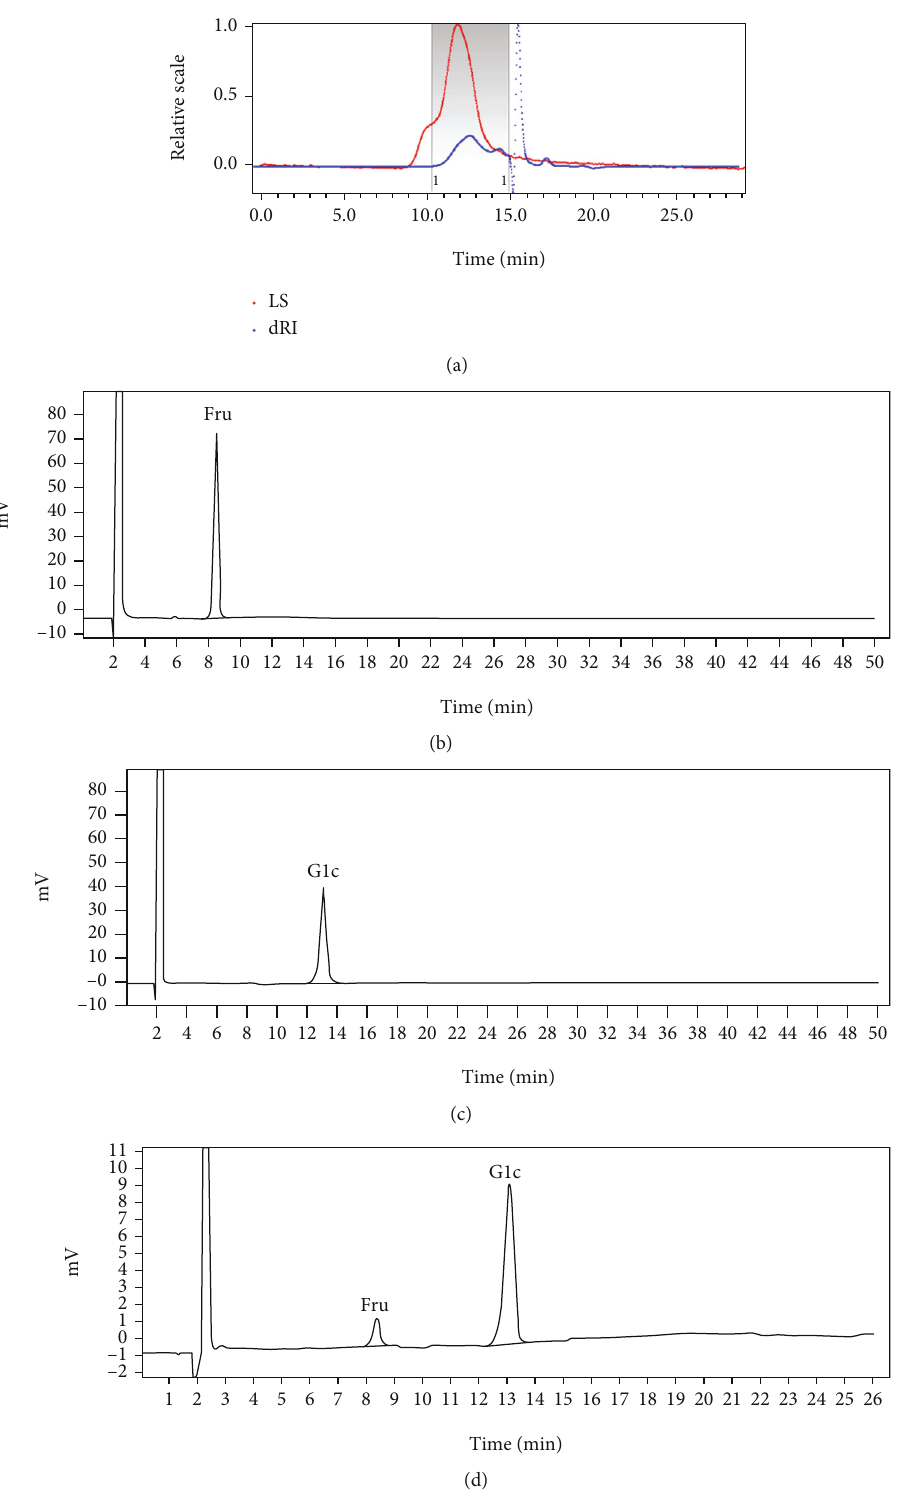
Figure 2: GPC-MALLS-RI chromatography of GBP (a). HPLC-RI analysis of fructose (b), glucose (c), and GBP hydrolyzates